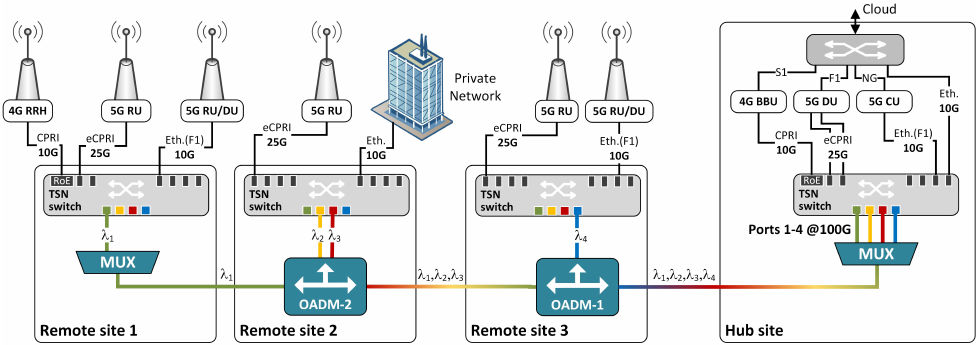
Figure 1. Example of optical TP from remote site 1 to the hub with wavelength aggregation by means of OADMs at intermediate remote sites 2 and 3 in packet-optical xHaul access network supporting 4G, 5G, and private network